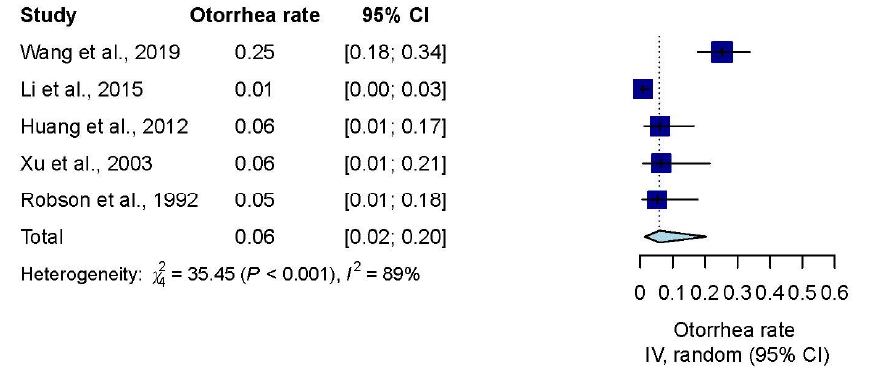
Figure 4. Effect estimate of post-VTI otorrhea rate.